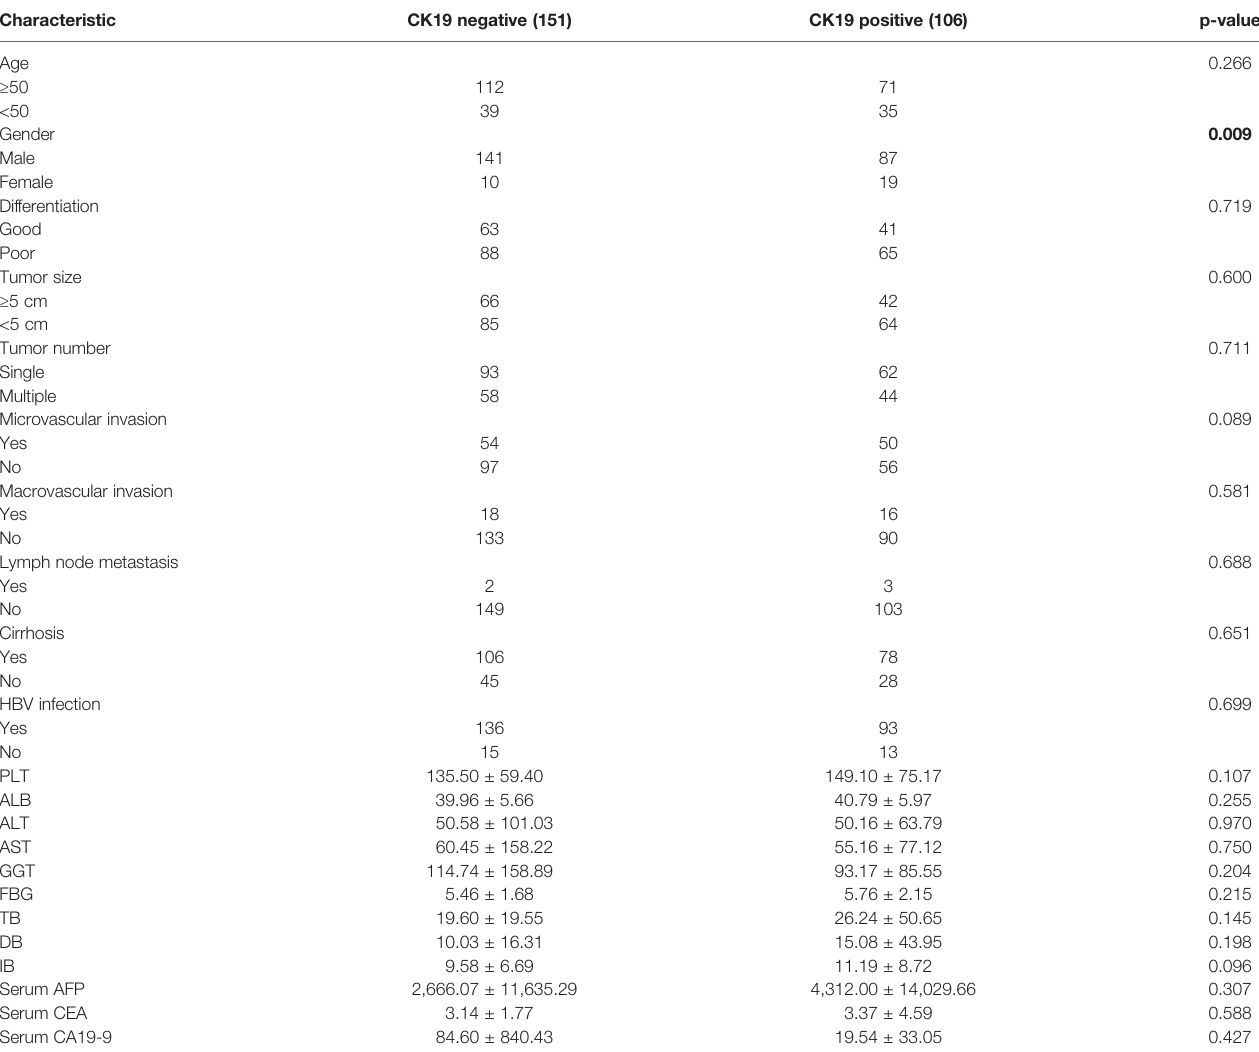
TABLE 1 | Clinical Characteristics of the Study Population.